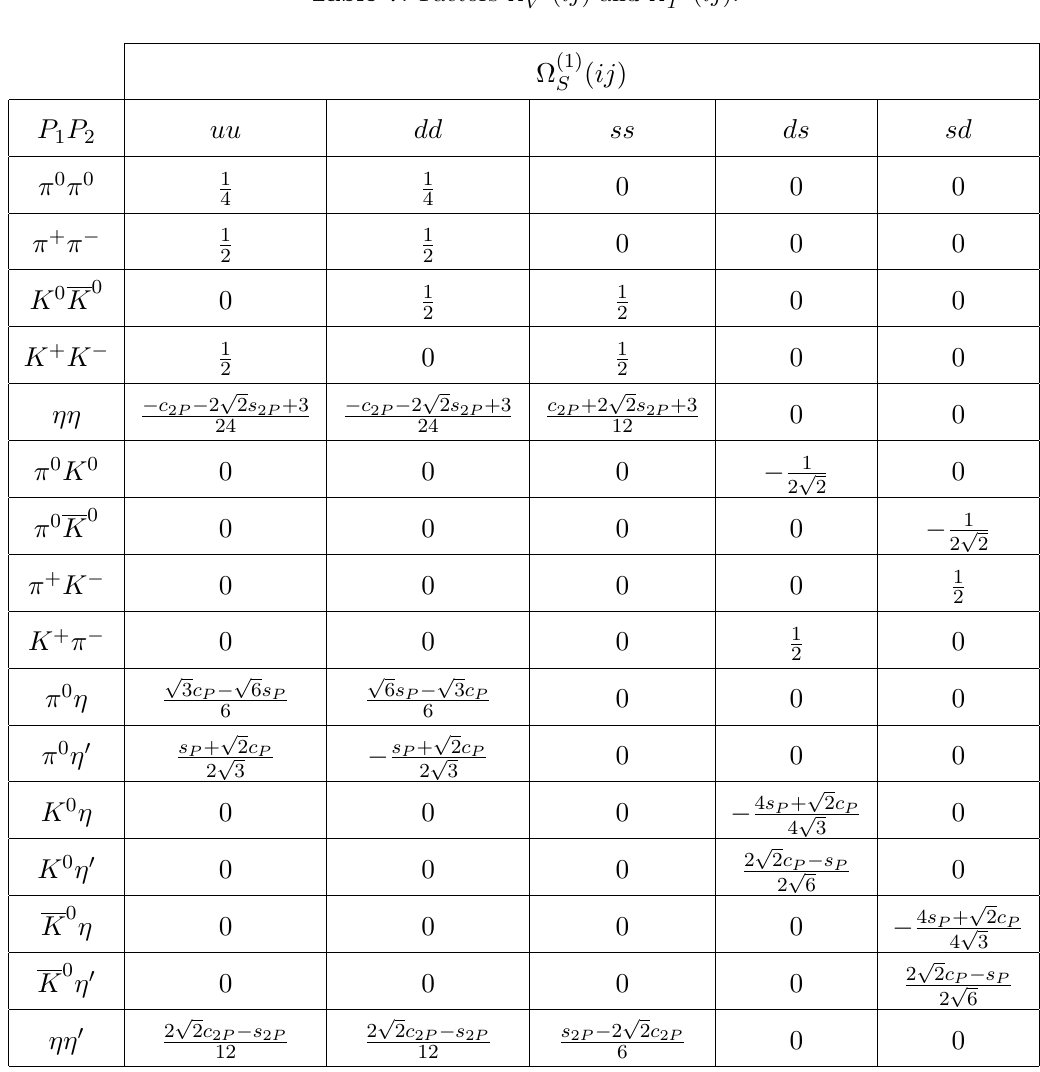
Table 7 . Factors Ω (1)